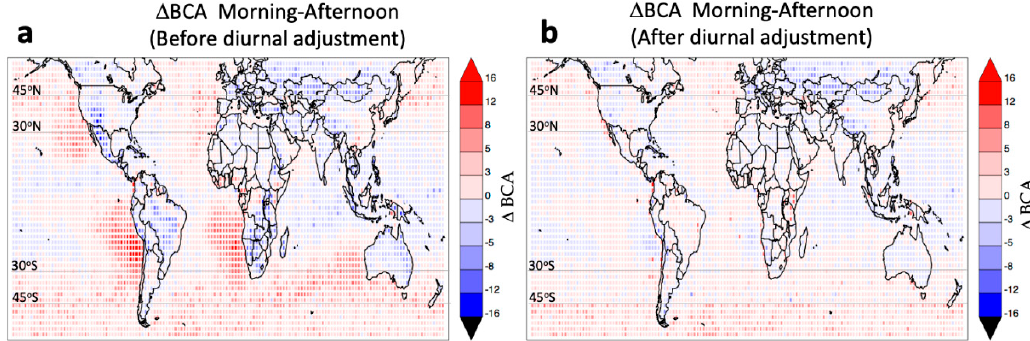
Figure 2. BCA difference between morning (8:15 a.m. to 11:15 a.m. local time) and afternoon (12:45 p.m. to 3:45 p.m.) for ( a ) un-adjusted BCA, and ( b ) after diurnal